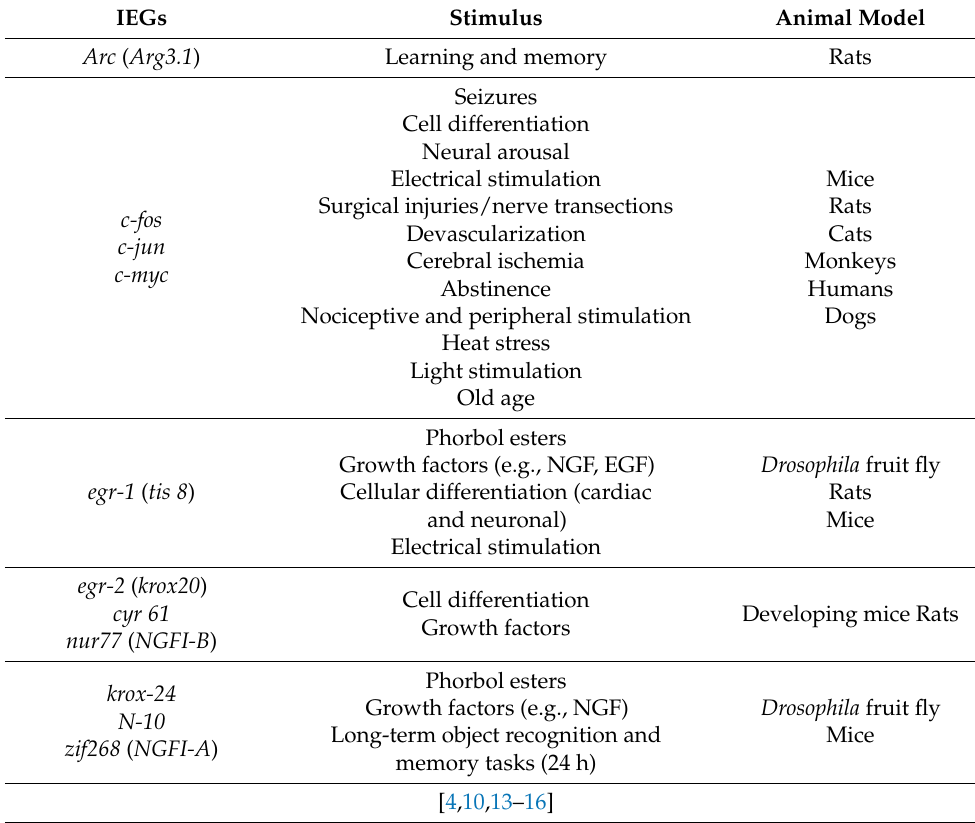
Table 2. Stimuli and animal models that lead to the expression of some